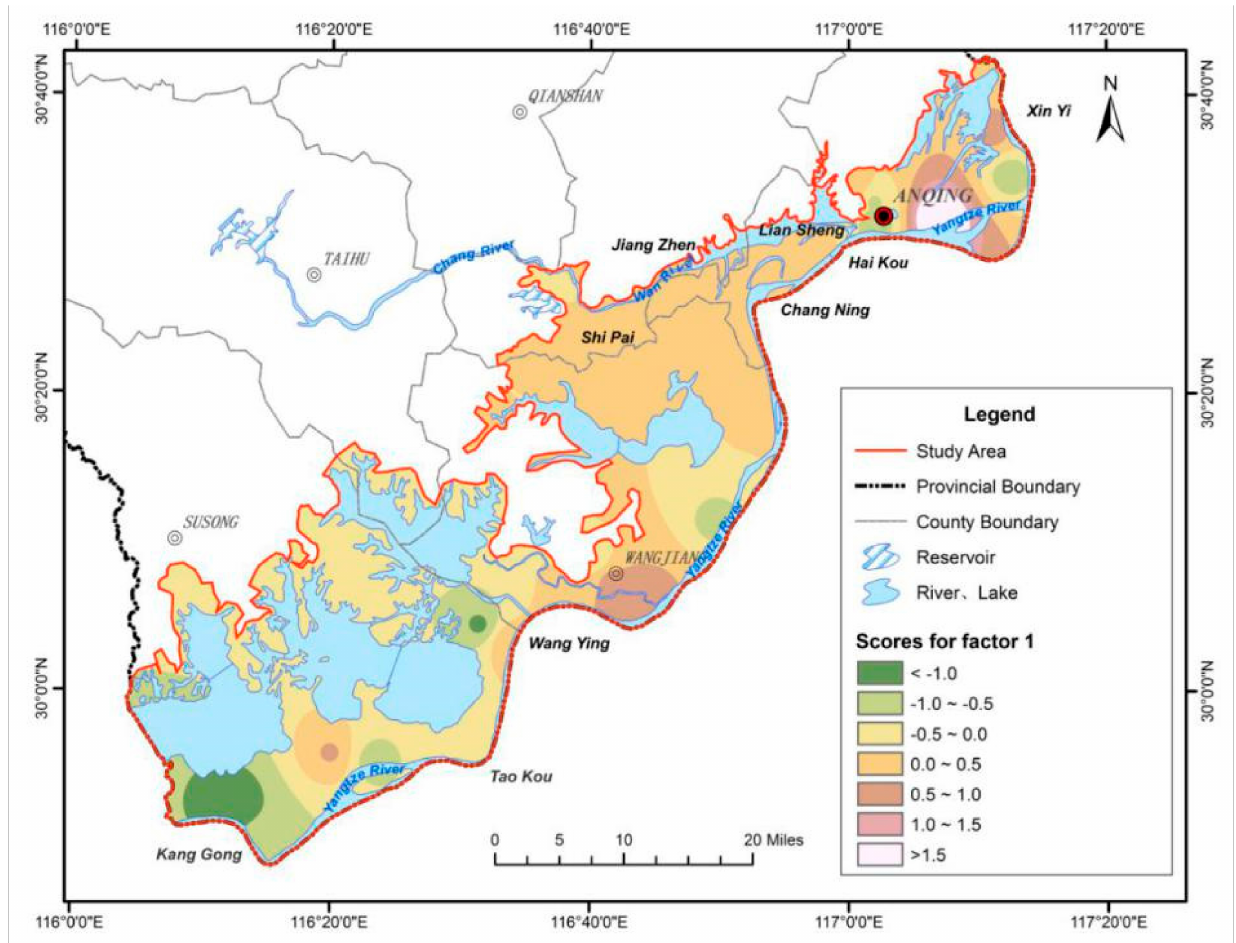
Figure 6. Distribution of scores of factor 1 for phreatic